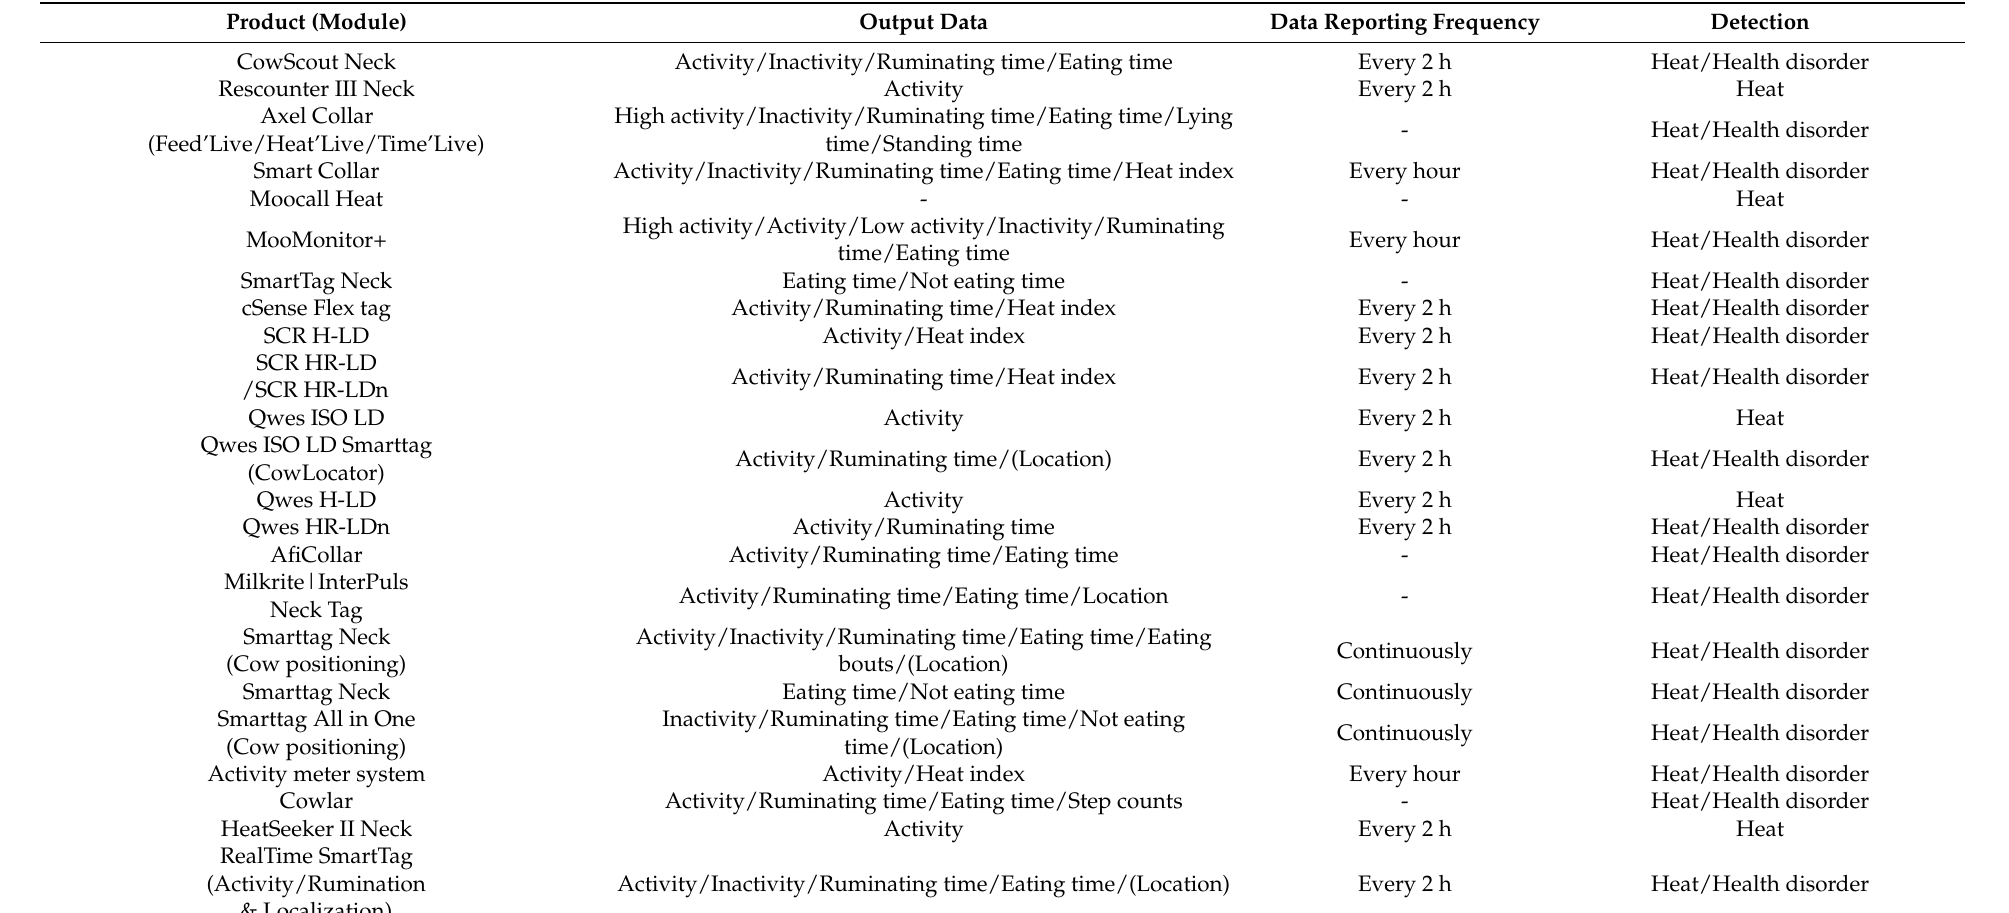
Table 4. Output data and detection items of the wearable wireless biosensor systems (neck collar